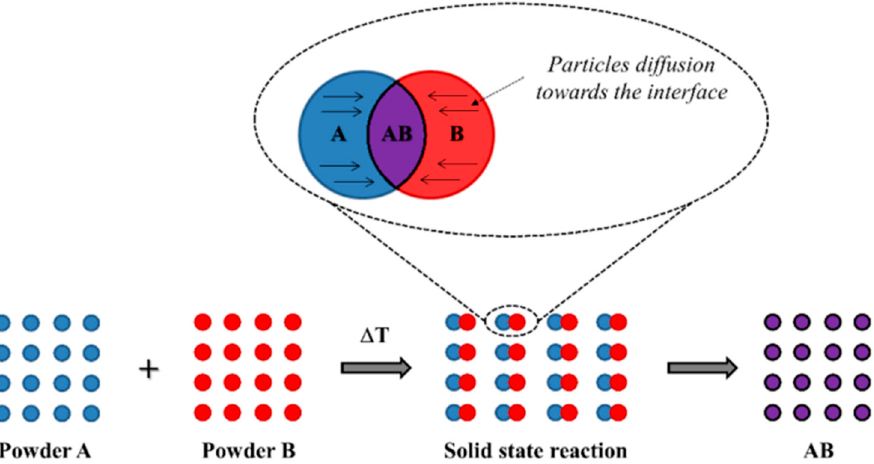
Figure 8. Schematic showing particle diffusion during the solid-state reaction (Reprinted with permission from [42]).